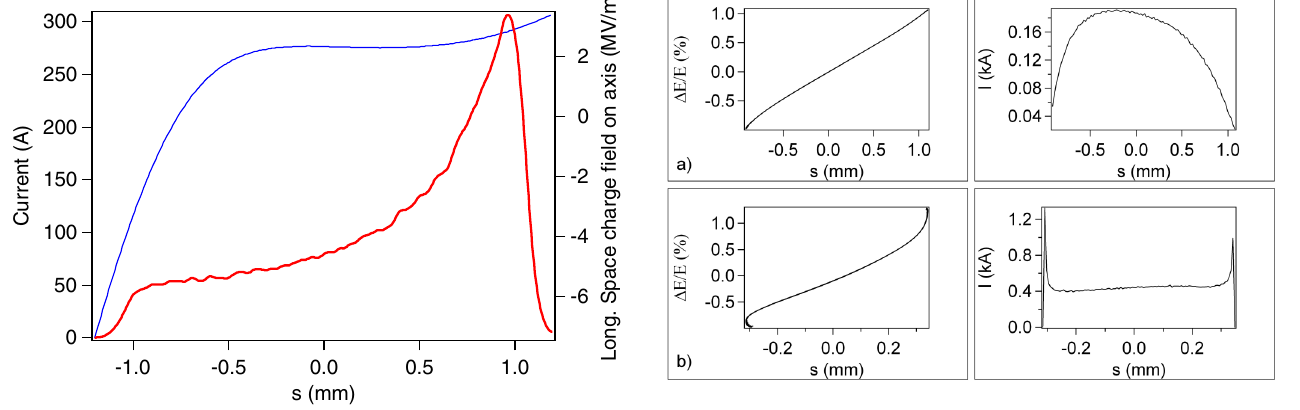
FIG. 5. (Color) The electron density distribution at the cathode (red curve) that evolves into the distribution with a linear ramped peak current shown in Fig. 4(a) with the black curve. The on-axis longitudinal space charge field (blue curve) of this distribution has a significant plateau